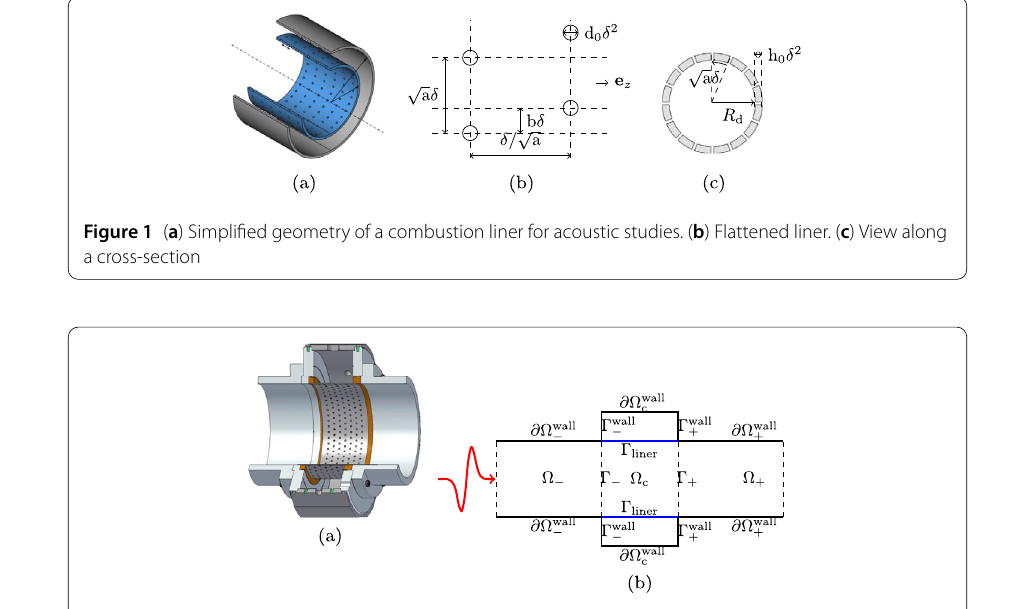
degenerates to an interface Γ liner liner